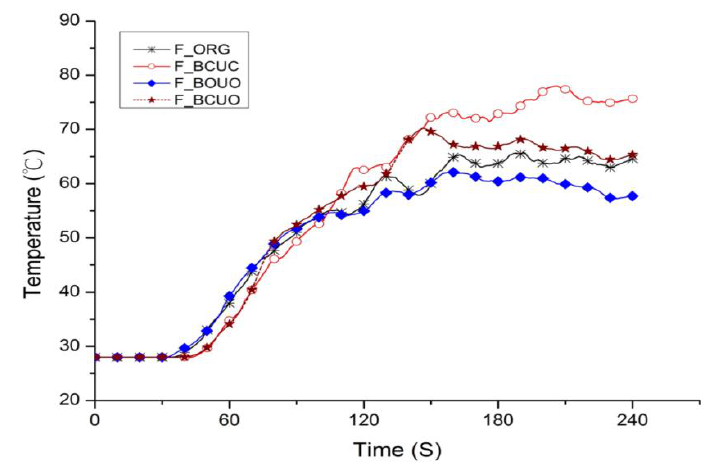
Energies 2016 , 9 , 192 Figure 24. Temperature curves of the roof above Point R. Figure 24. Temperature curves of the roof above Point R.